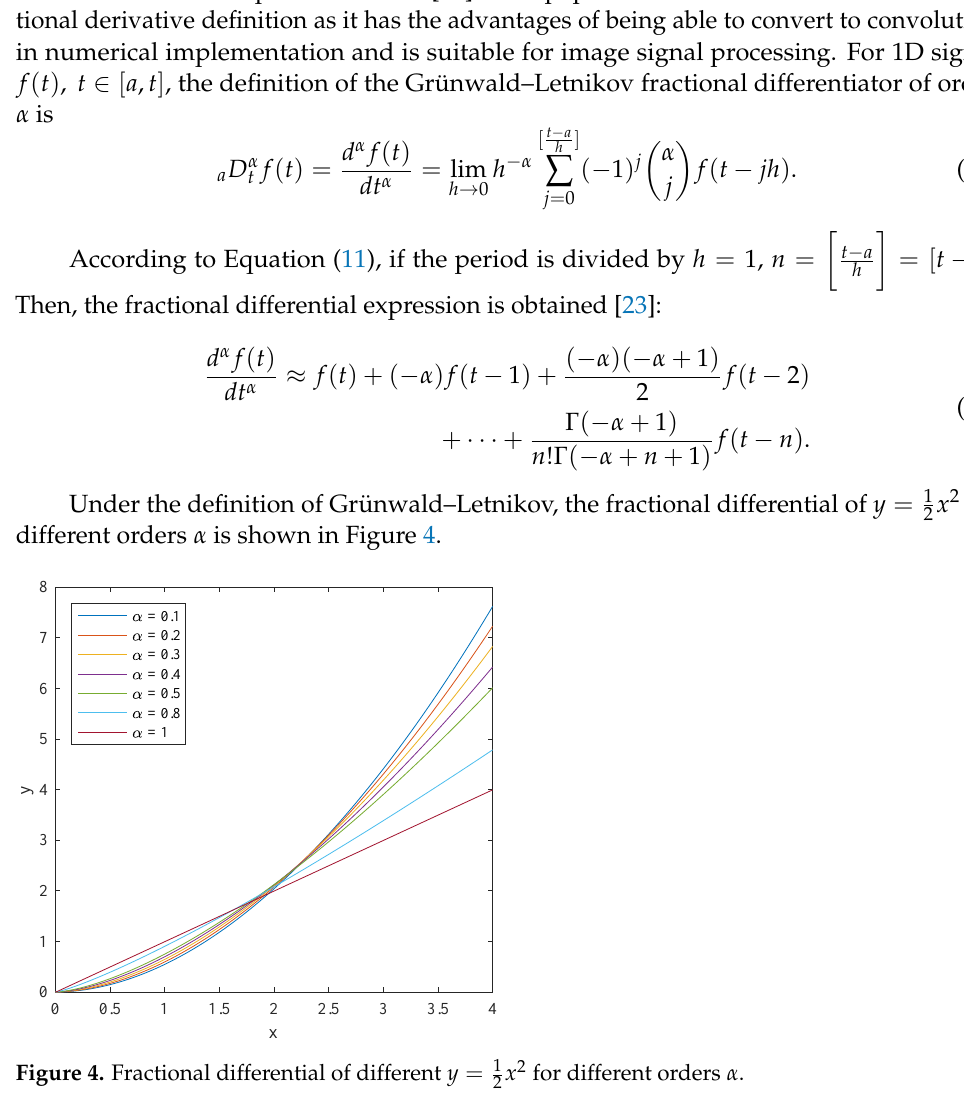
Figure 4. Fractional differential of different y = 1